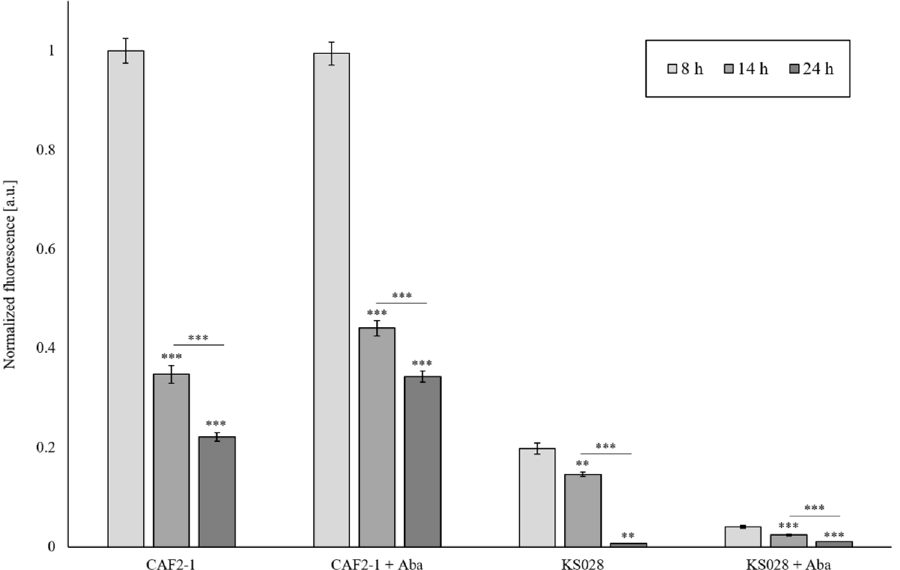
Figure 7. The efflux of rhodamine 6G (R6G) determined in 8, 14, or 24 h cultures, with or without the supplementation of 0.005 µ g/mL Aureobasidin A (AbA) for C. albicans CAF2-1 and C. albicans KS028 ( erg11 ∆ / ∆ ). Statistical analysis was performed by comparing rhodamine efflux between the C. albicans CAF2-1 and KS028 strains during different growth phases (** p < 0.01; *** p < 0.001). Table 1. H + -ATPase activity measured by pH change after 200s., as determined for C. albicans CAF2-1 (WT) and KS028 ( erg11 ∆ / ∆ ) strains. Cells for testing were taken after 8, 14, and 24 h of culture. The percentage of the difference between the number of units by which the pH decreased in the control (without the addition of AbA) and sample with the addition of AbA (0.005 µ g/mL). 8